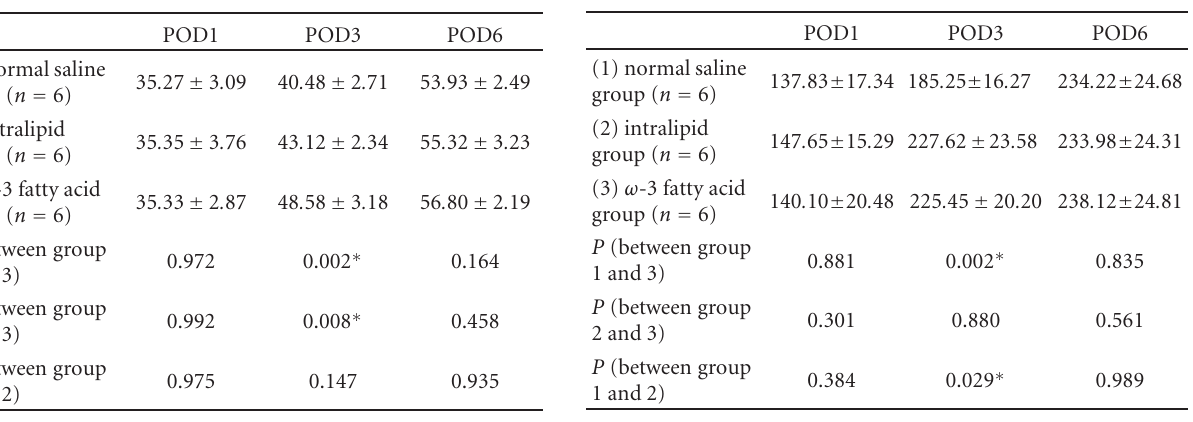
Table 2: Small bowel propulsion rate (%).